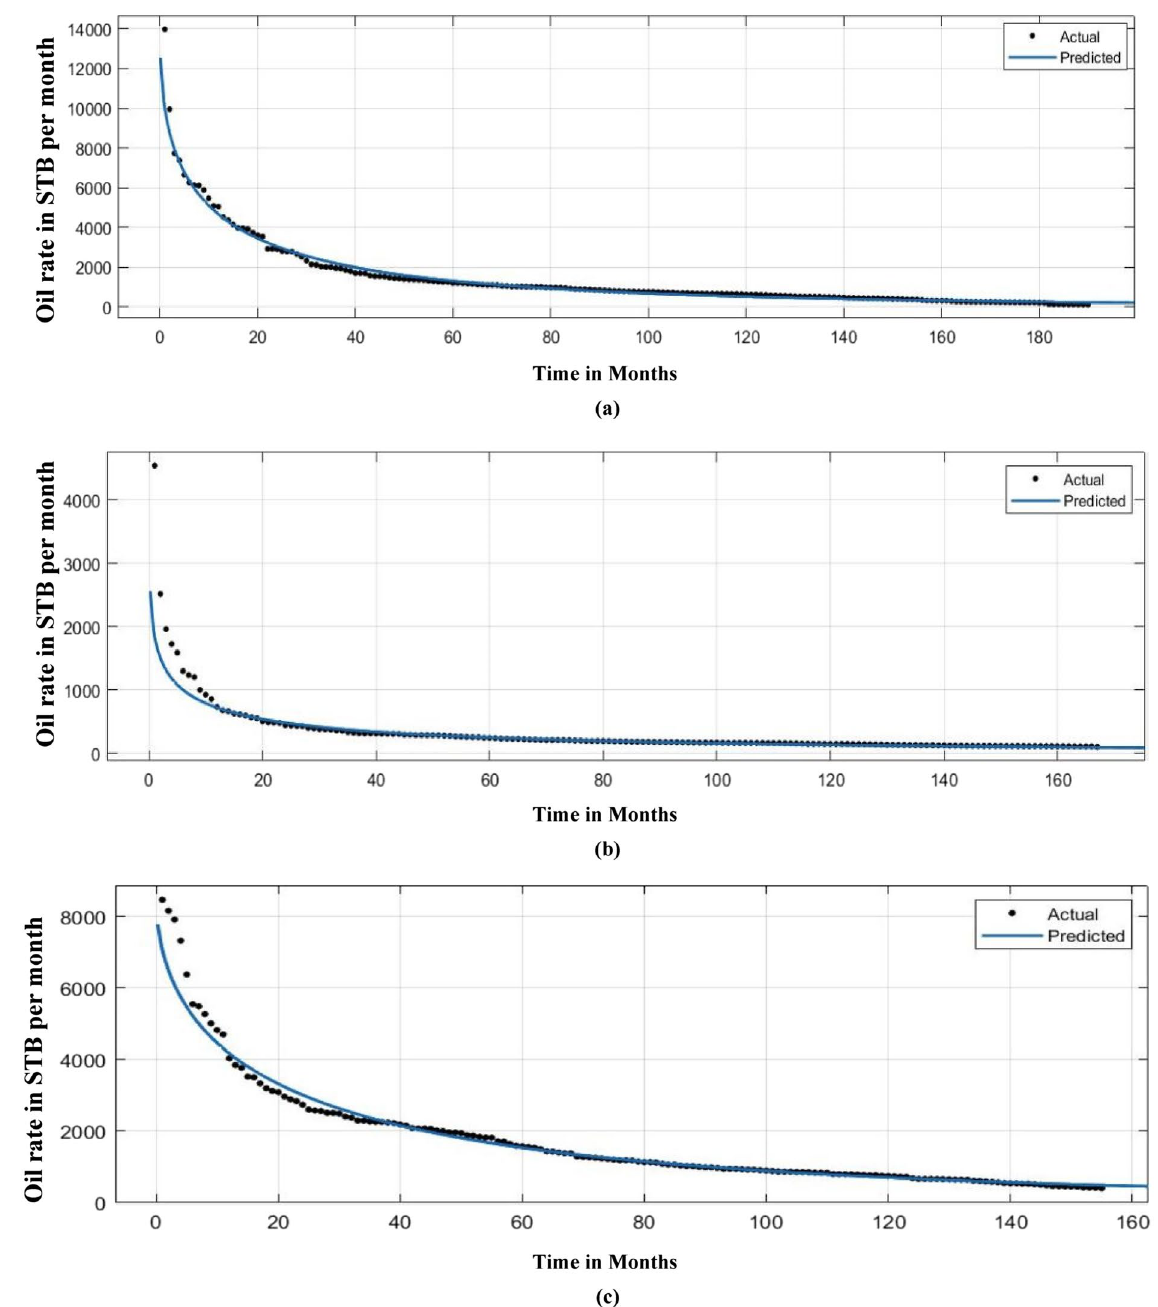
Figure 21. Fitting of SEDM decline model-based prediction for test